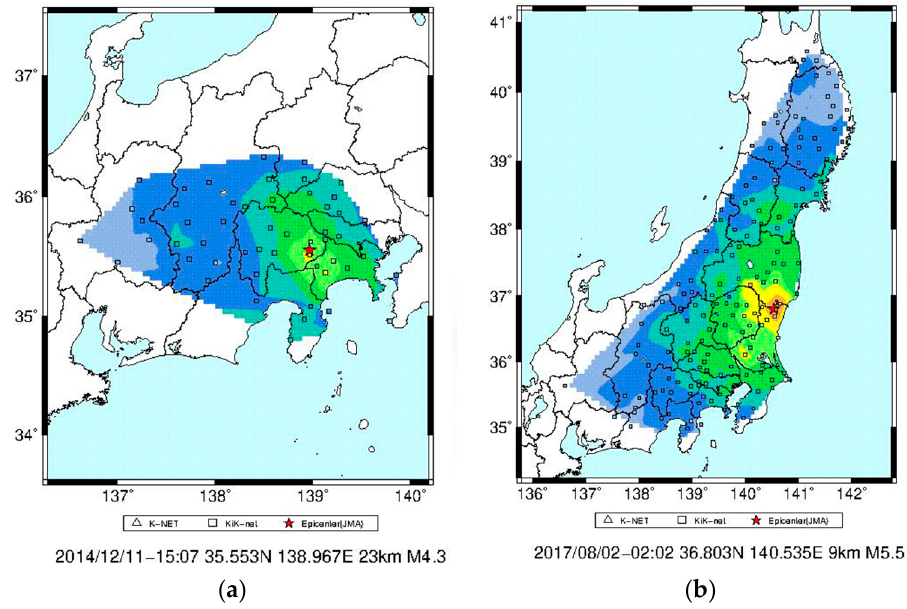
Figure 7. Distribution of epicenter stations for magnitudes M j4.3 ( a ) and M j5.5 ( b ). Available online: www.kyoshin.bosai.go.jp (6 July 2022).